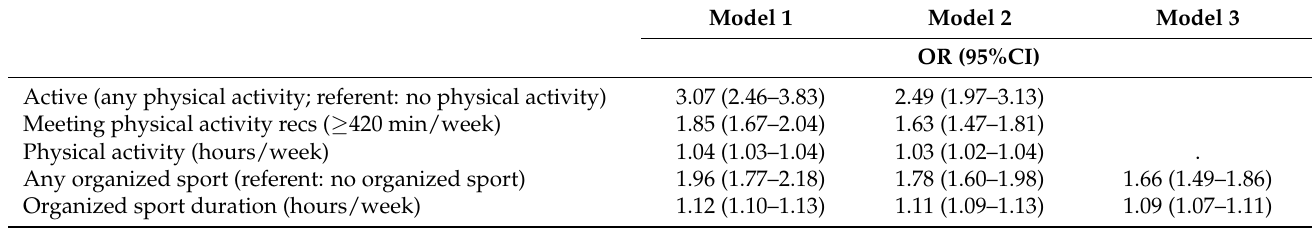
Table 2. Binary logistic regression analyses examining the association between physical activ- ity/organized sport participation and